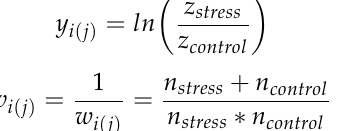
Figure 2. Simple relationships between grain yield (Mg ha –1 , expressed in dry basis) and grain concentration (%) of protein ( A ), starch ( B ), and oil ( C ) (all adjusted to dry basis). For each component, data points belong to multiple studies where both grain yield and the component of interest were quantified.